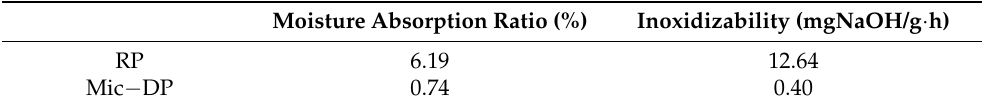
Table 3. The hygroscopicity and oxidation of RP and Mic − DP.